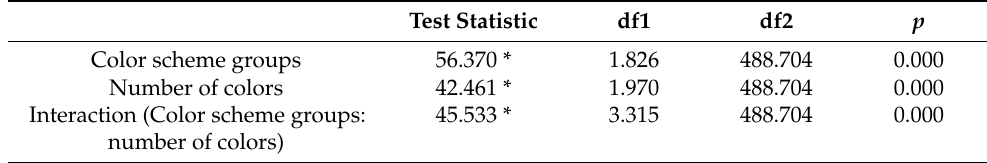
Table 6. The results of the ANOVA-type statistics.